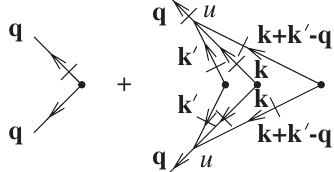
FIG. 4. Two-loop renormalization of the noise vertex: There is no fluctuation correction to first order in u ; the two-loop graph represents the lowest-order contribution to the vertex function Γ q ; ω Þ ~ ψ (cid:2) ~ ψ ð